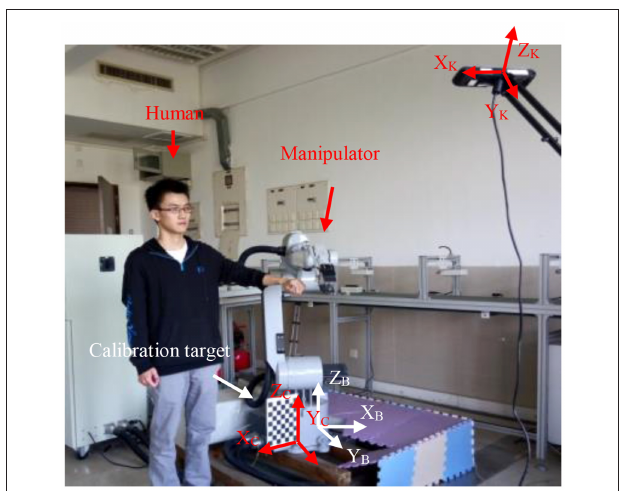
FIGURE 4 | Experiment environment (the person is Dolin and he consents for the Publication of the